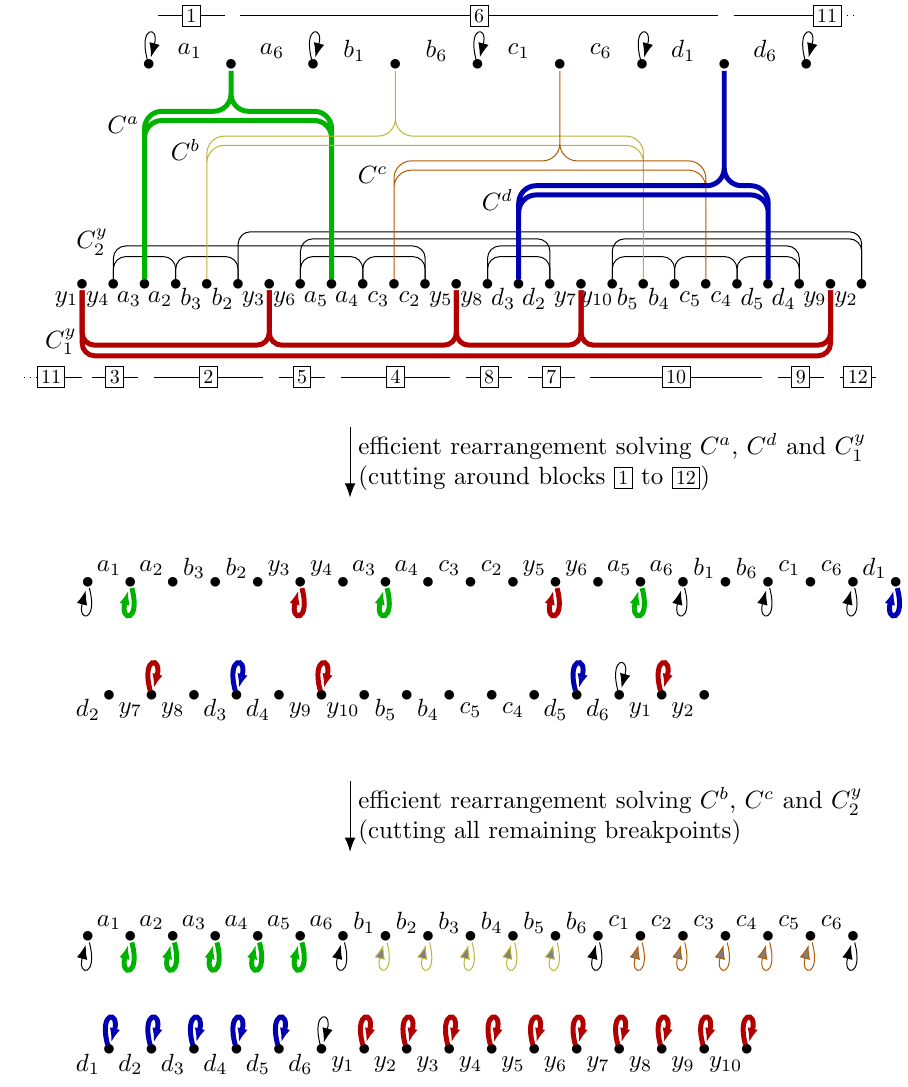
Figure 6. Illustration of the reduction from a simplified version of E XACT C OVER , with size-2 sets over a size-4 universe U = 1,2,3,4 : A = 1,2 , B = 1,4 , C = 2,4 , D = 3,4 (for lighter { } { } { } { } { } indices we use a , b , c , d instead of x 1 , x 2 , x 3 , x 4 ; note also that we have a i for 1 6 instead i ≤ ≤ ( S , T ) are depicted on of 1 8 because of the smaller sets). All six non-trivial cycles of i ≤ ≤ C the top permutation: C a = , C b , etc. In this example, ( S , T ) admits an efficient 11-cut a 1 , a 3 , a 5 { } rearrangement corresponding to an exact set cover of U : cut all breakpoints in bold cycles C a , C d , C y , 1 followed by an efficient 19-cut rearrangement solving the remaining breakpoints (in the actual reduction, we consider instances where 7 n = 8 p to enforce that both efficient rearrangements have the same size k